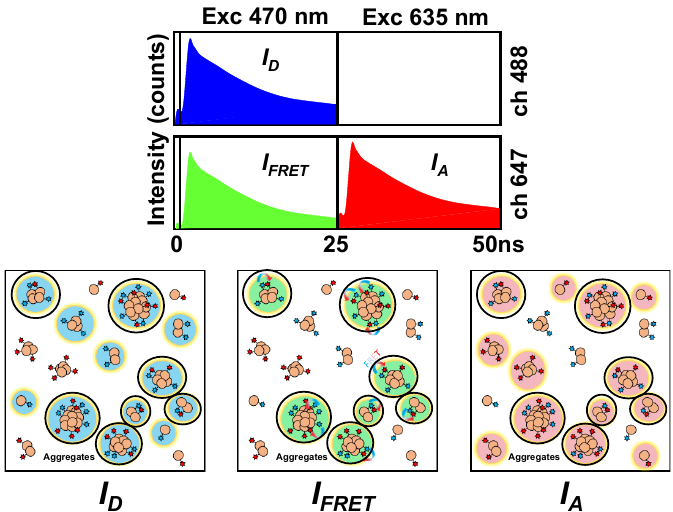
Figure 1. Dual-color pulsed interleaved excitation–fluorescence lifetime imaging microscopy (PIE-FLIM) scheme and aggregate selection criteria. The three different time gates distributed in the two detection channels define the reconstructed I D , I FRET , and I A images. The three images are then analyzed to identify fluorescent events. Only coincident pixels in all three images are selected as aggregates (indicated with dark circles in the cartoon).